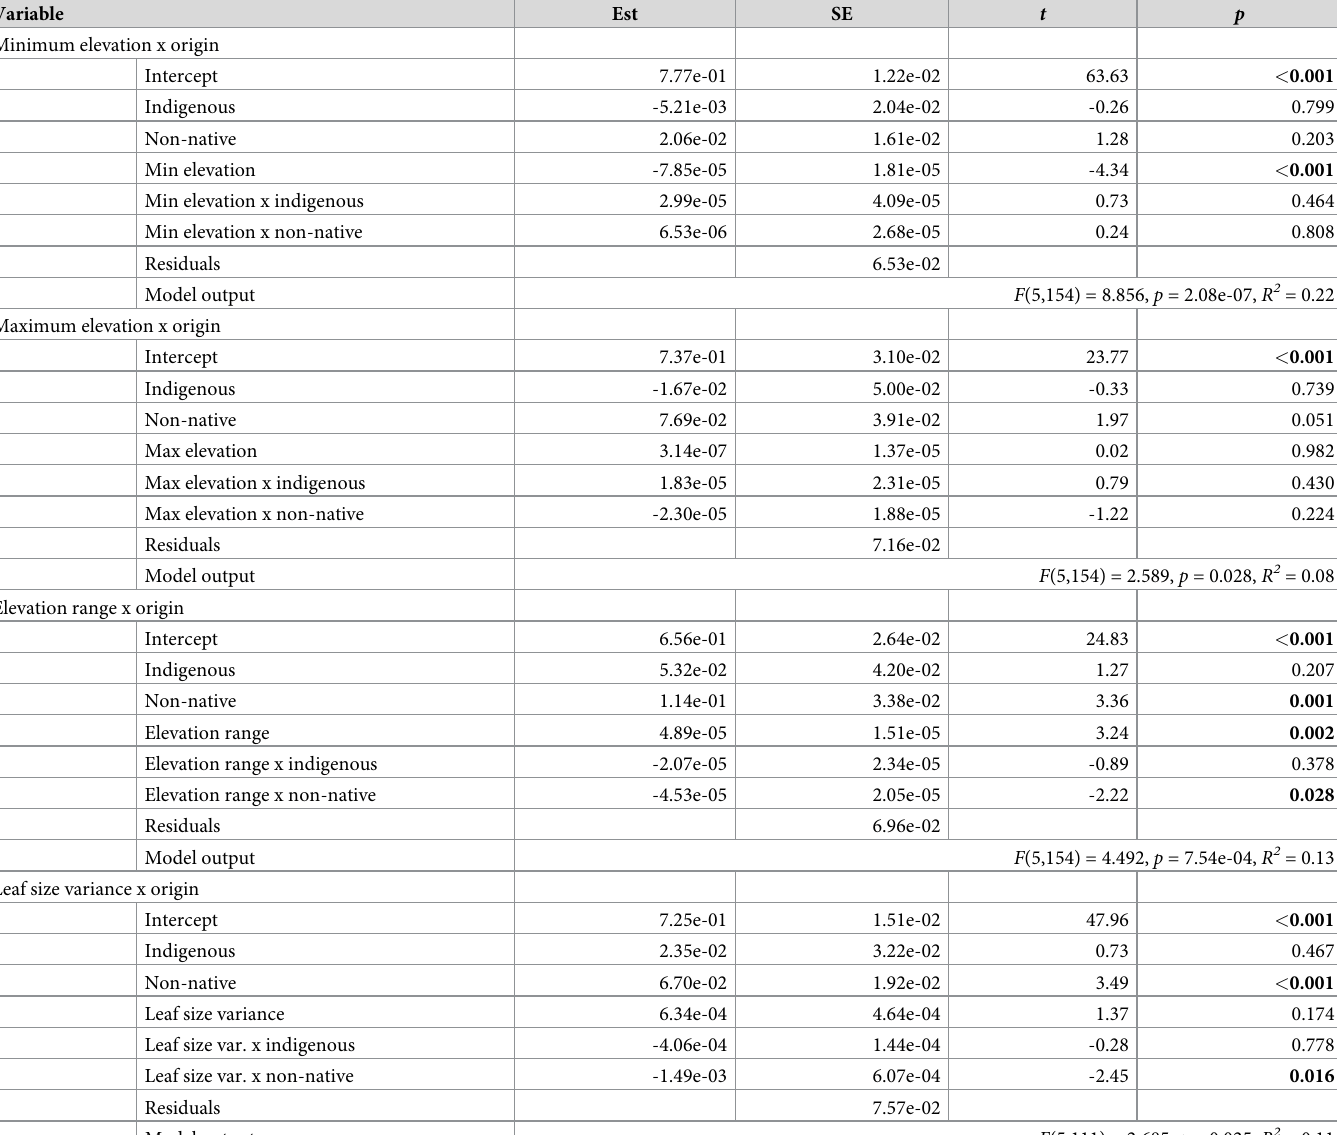
Table 6. Linear models. Developed to examine if and to what extent habitat specialization (Jaccard index) differs across continuous variables (elevation minimum, eleva- tion maximum, elevation range, leaf size variance) and biogeographic origin. Models test the null hypotheses that (1) the Jaccard index is zero (Intercept = Endemic, Indig- enous, Non-native) when controlling for the continuous variable and (2) that there is no relationship (slope = 0) between the Jaccard index and the continuous variable. Bold p values indicate significant differences from the null hypotheses. The minimum elevation and elevation range models had significant slopes; however, only the mini- mum elevation model explained greater than twenty percent of the variance in the data ( R 2 ) with endemic species displaying the steepest slope (Fig